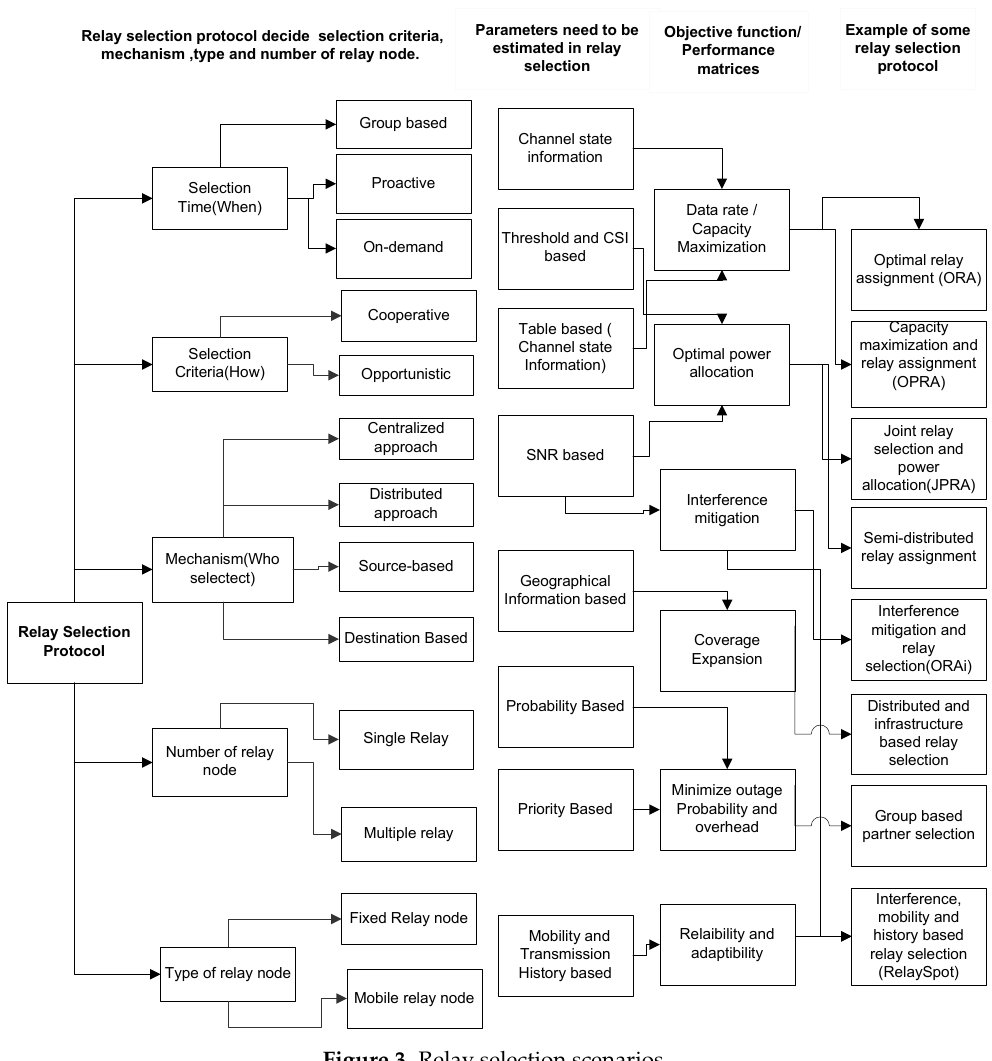
Figure 3. Relay selection